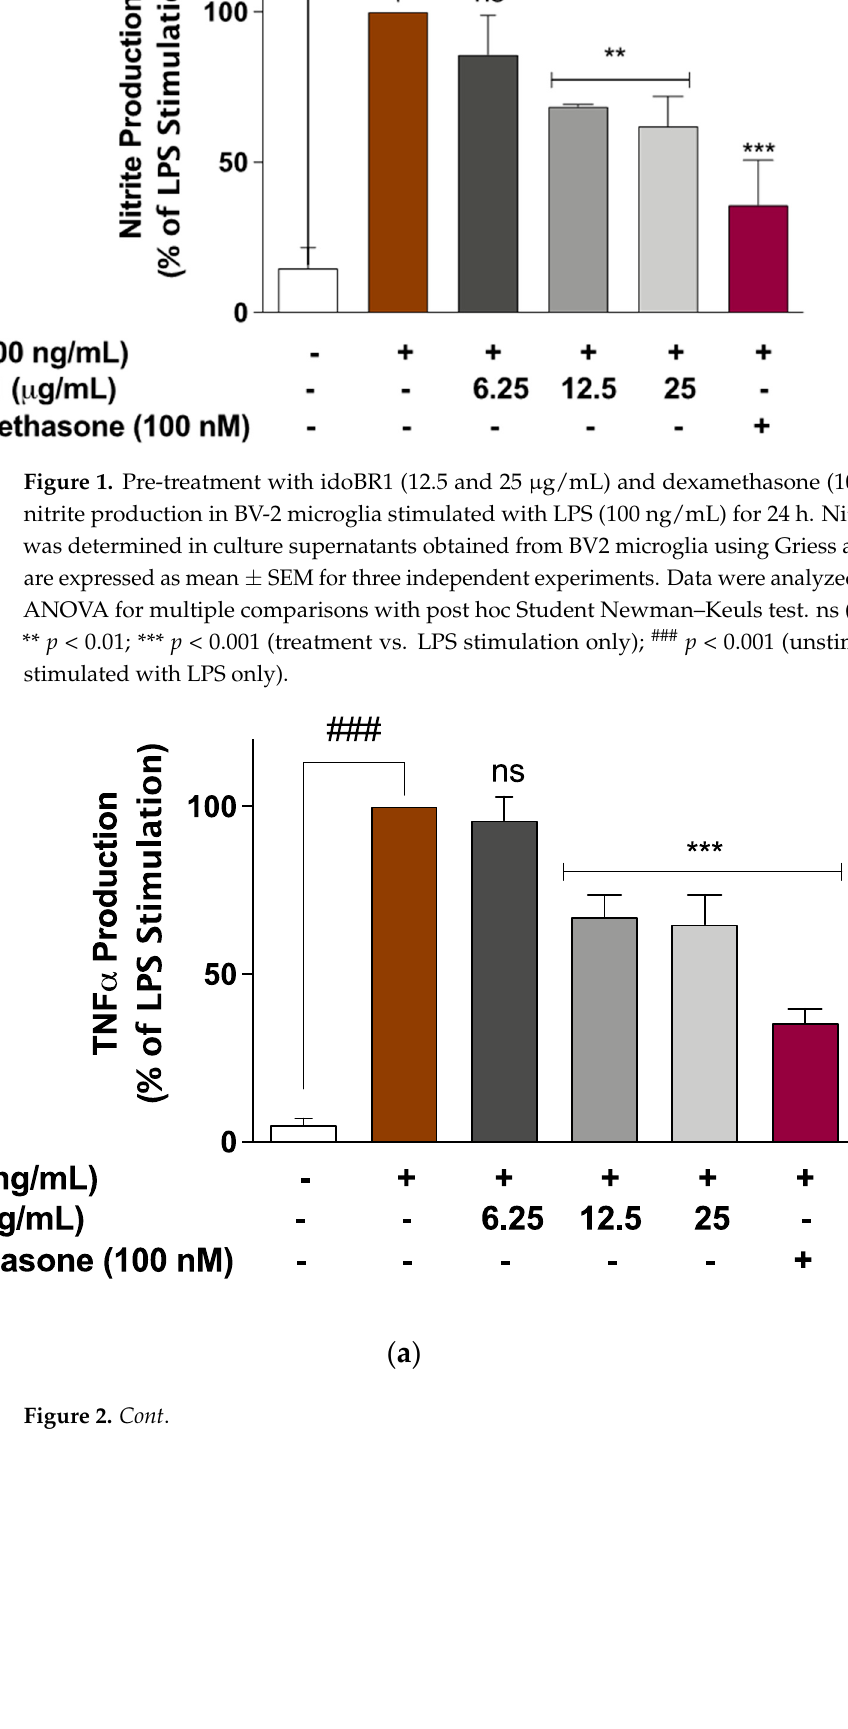
Figure 1. Pre-treatment with idoBR1 (12.5 and 25 µg/mL) and dexamethasone (100 nM) reduced nitrite production in BV-2 microglia stimulated with LPS (100 ng/mL) for 24 h. Nitrite production was determined in culture supernatants obtained from BV2 microglia using Griess assay. All values are expressed as mean ± SEM for three independent experiments. Data were analyzed using one- way ANOVA for multiple comparisons with post hoc Student Newman–Keuls test. ns (not signifi- cant); ** p < 0.01; *** p < 0.001 (treatment vs. LPS stimulation only); ### p < 0.001 (unstimulated cells vs. stimulated with LPS only).